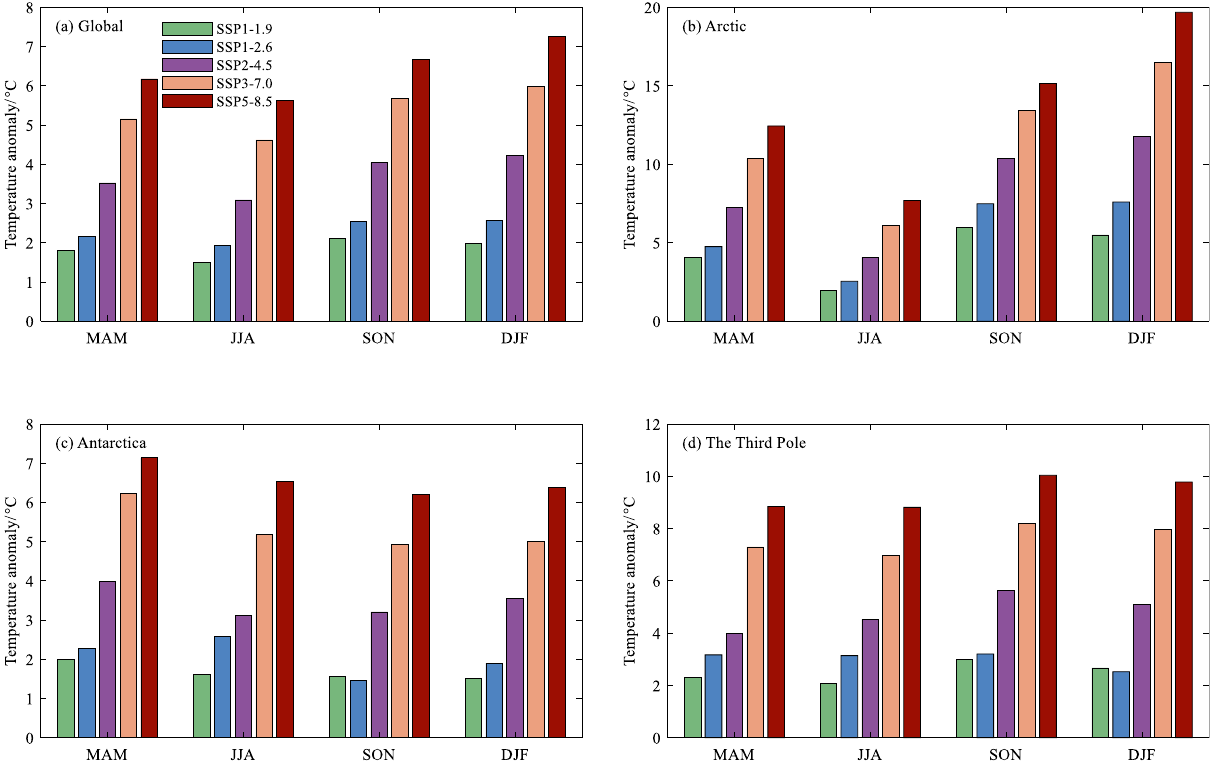
Figure 4. Surface air temperature anomaly (°C,1850–1900 as the baseline period) for seasonal mean for ( a ) Global, ( b ) Arctic, ( c ) Antarctica and ( d ) The Third Pole in 2100 from multi-model ensemble mean (MMEM) of the CMIP6 simulations under SSP1-1.9 (green), SSP1-2.6 (blue), SSP2-4.5 (purple), SSP3-7.0 (orange), SSP5-8.5 (bronze), respectively. The season mean is from the three monthly average of MAM (March–May), JJA